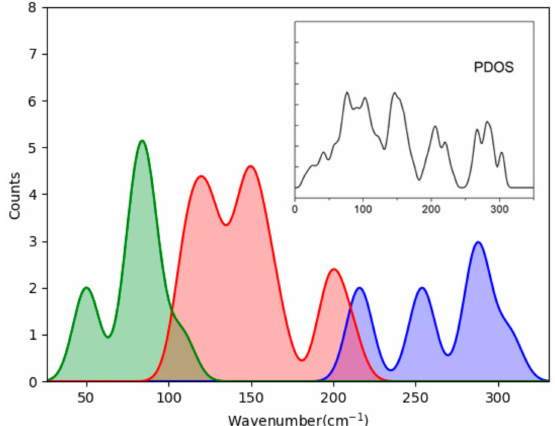
Figure 3. Fitted curves of four-bond modes (blue), two-bond modes (red), and cluster modes (green) of ice II in the translation band. The inset PDOS curve is shown for comparison. Note that the fitted curves are related to the Brillouin zone (BZ) center only, while the PDOS is integrated over the entire BZ. − 1 The H–O–H bending band has 12 normal modes from 1659 to 1723 cm . These vibrations can be − 1 divided into in-phase and out-of-phase modes. The vibrations at 1659 and 1723 cm that possess the lowest and highest energy in this band all present out-of-phase modes, as shown in Figure 4. An − 1 exception is the mode at 1703 cm , in which all molecules vibrate in-phase. Two peaks at 1690 and − 1 1748 cm were detected by IR absorption [22]. These correspond to the normal modes of 1680 and − 1 1723 cm , according to the calculated IR intensities. For the Raman spectroscopy experiment, no peaks were detected in the bending area due to the weak intensity. The INS experiment detected a − 1 − 1 peak at 1669 cm that corresponds to 1664 and 1699 cm in PDOS